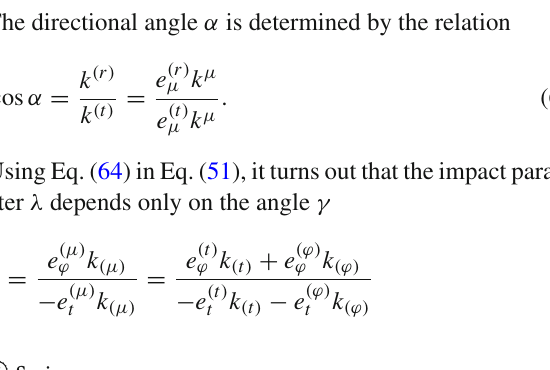
L with their dependence on λ (shaded areas, with the trapped region beingdarker).Allofthefiguresareforthespecificcaseofnullgeodesics emitted from the equatorial plane at radius r 0 = 1 with λ = − 4